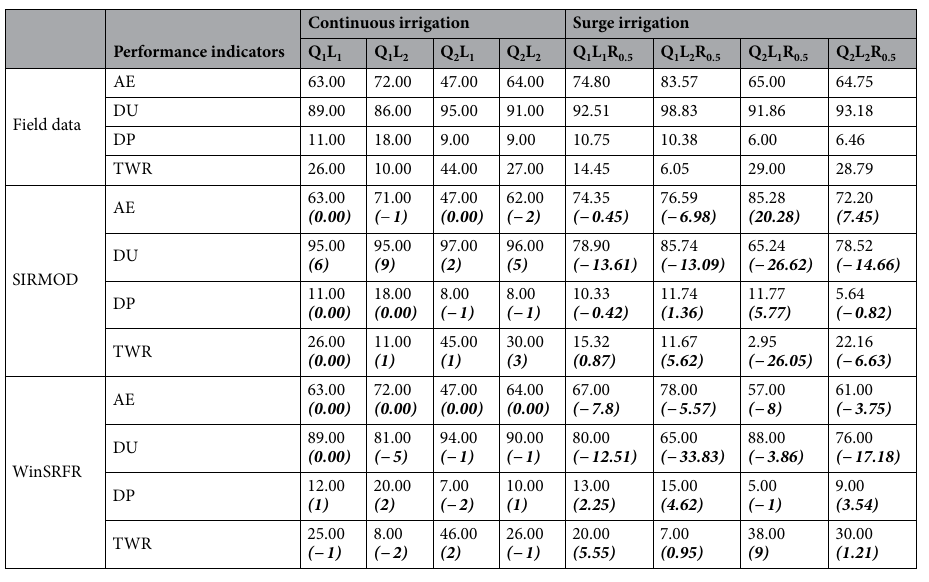
Table 7. Irrigation performance indices (%) measured in the field and simulated by SIRMOD and WinSRFR for the continuous and surge irrigations. Q: stream size; L: furrow length; R 0.5 : surge irrigation with cycle ratio of 0.5. The Italic values in parenthesis (%) are the difference between the simulated value and the corresponding measured